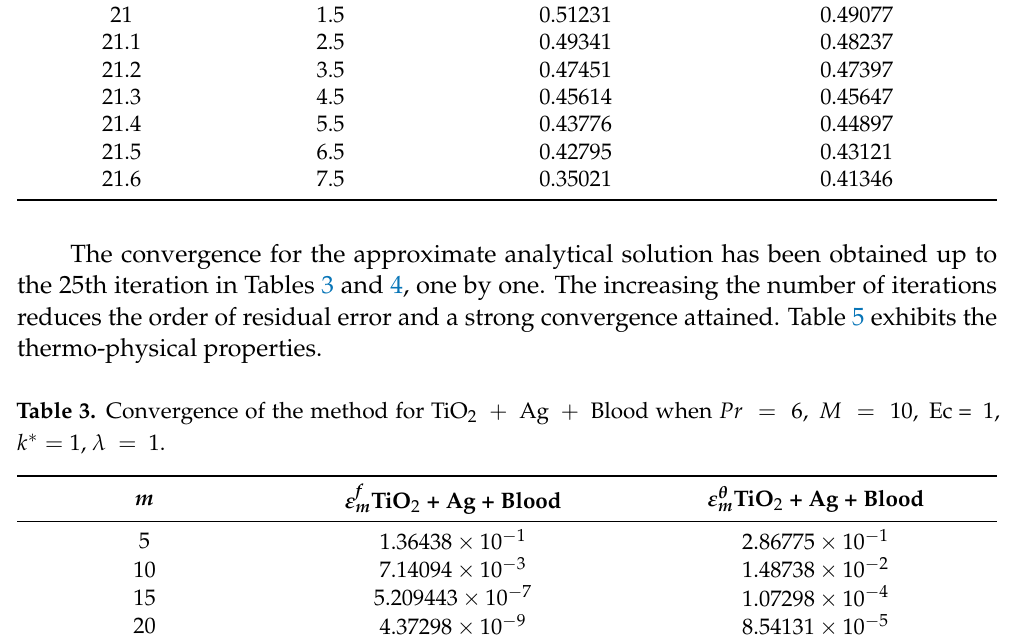
− 1 2 x Nu x ) for the two nanofluids when k ∗ = 0.5, M = 2,